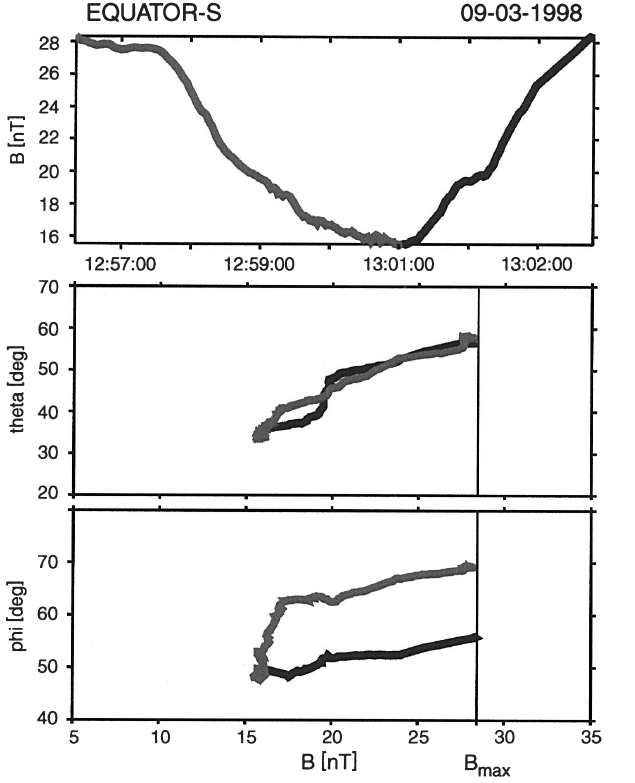
Fig. 6. An example of the detailed variation of magnitude ( B ), polar angle (theta), and azimuth (phi) of the magnetic field in one of the field depressions (plasma blobs) observed on 9 March 1998. Theta and phi are plotted versus B , decreasing phase indicated by thick line